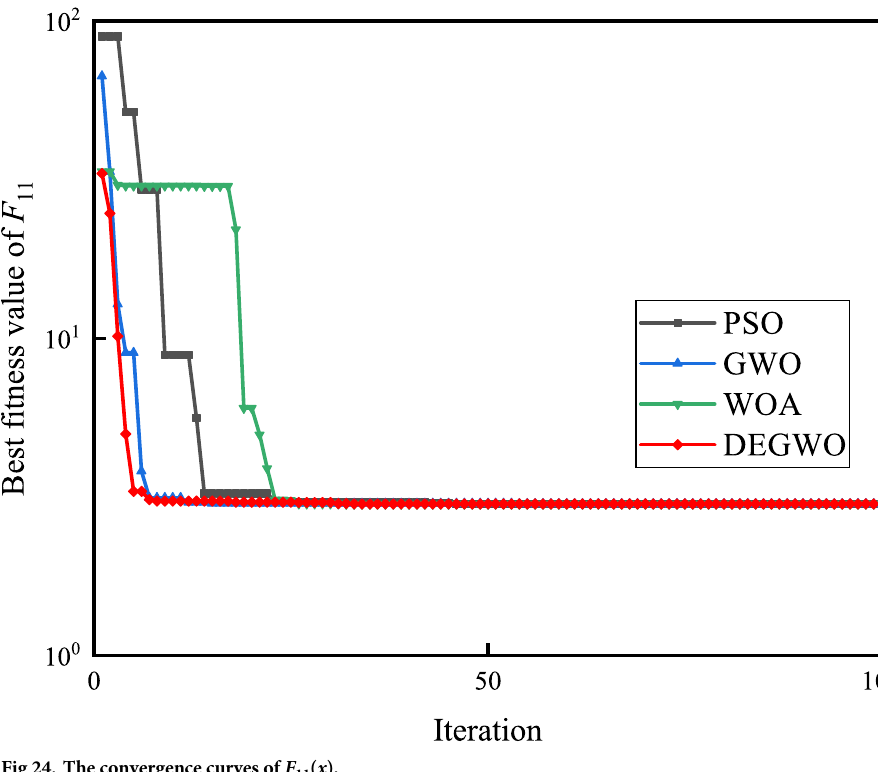
Fig 24. The convergence curves of F 11 ( x ).